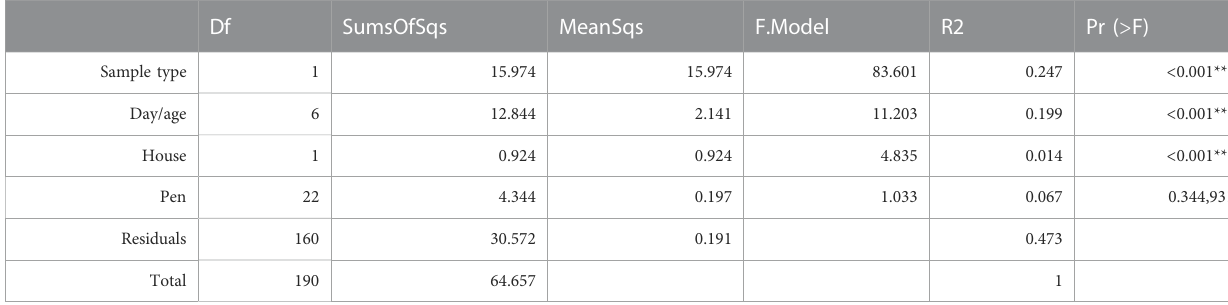
TABLE 1 Results from a PERMANOVA test for the in fl uence of sampling groups.